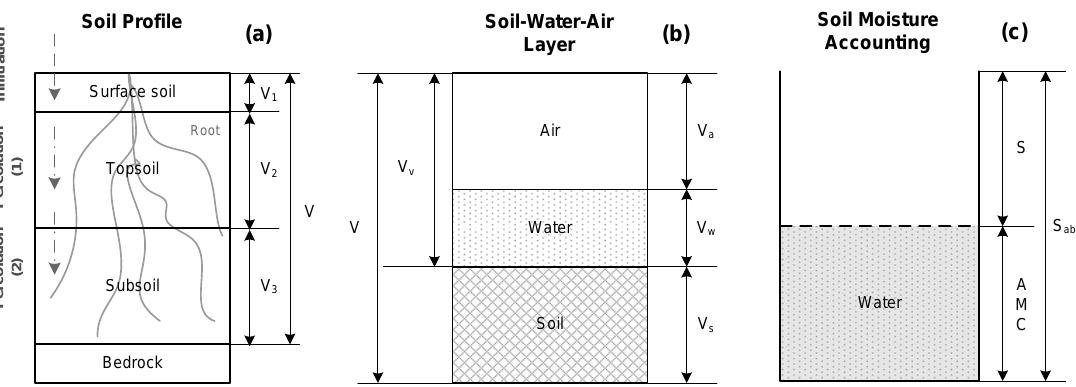
Figure 1. Schematic diagram of soil profile, soil-water-air layer, and a concept of soil moisture accounting. In this figure, V a is the volume of air, and V w is the volume of water. The sum of air and water represents as the total volume of voids, V v . S abs is the absolute capacity of S. V in Figure 1 is the total volume: ( a ) General soil profile; ( b ) Structure of soil-water-air layer; and, ( c ) Conceptual diagram of soil moisture accounting.